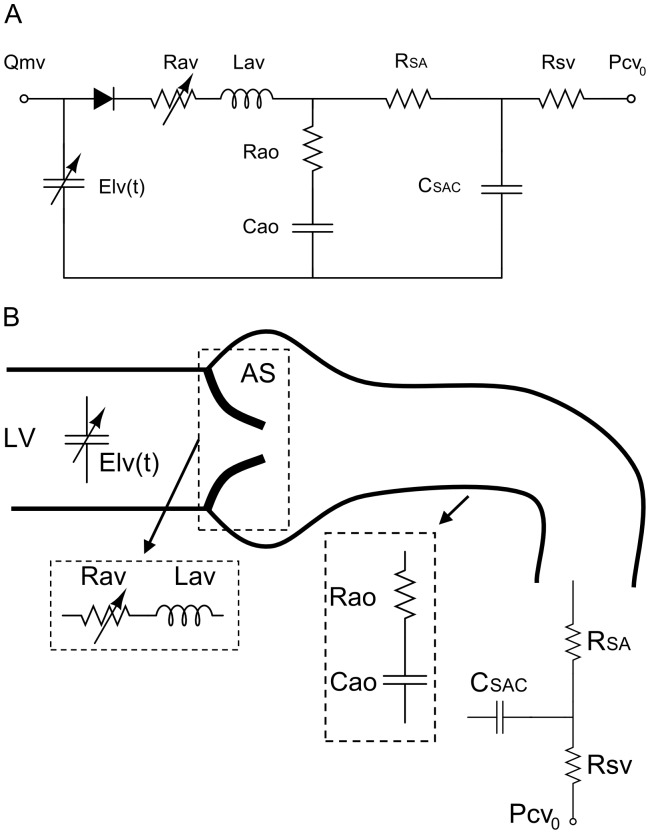
Schematic diagrams.(a) electrical representation, (b) schematic representation of the lumped parameter model used to simulate left-sided heart in presence of aortic stenosis and/or systemic arterial hypertension. LV: left ventricle, AS: aortic stenosis, Elv(t): normalized time-varying elastance (please see Table 1 for all other parameters used in the lumped parameter model).